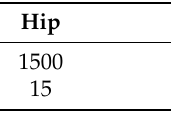
Figure 13. Control performance of the position outer loop and the force inner loop: ( a ) knee trajectory; ( b ) hip trajectory; ( c ) knee torque; ( d ) hip torque. Table 5. Impedance control